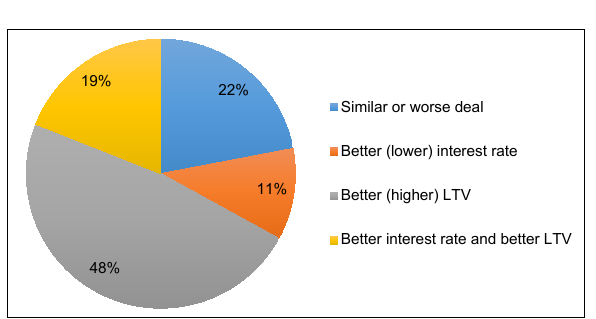
Breakdown of home loan offers taken up at another institution.